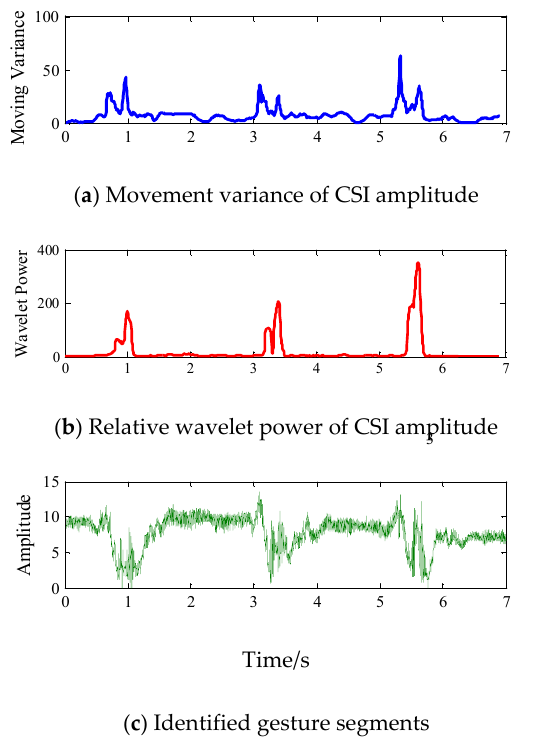
Figure 3. Illustration of motion detection and segmentation.